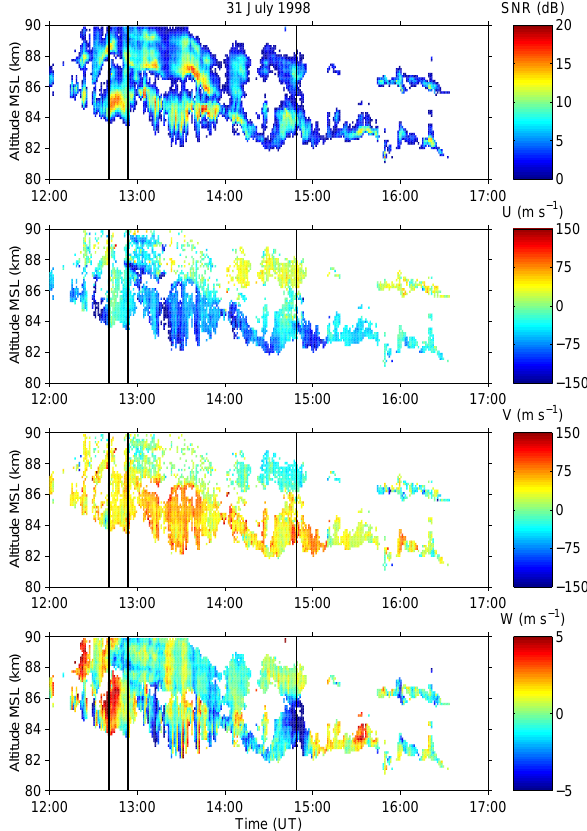
Fig. 1. Range-time pseudocolor plots of the signal-to-noise ratio (SNR); zonal (U) and meridional (V) components of the horizontal wind; and the vertical velocity (W). The black vertical lines are used to flag times that have been selected for closer examination.